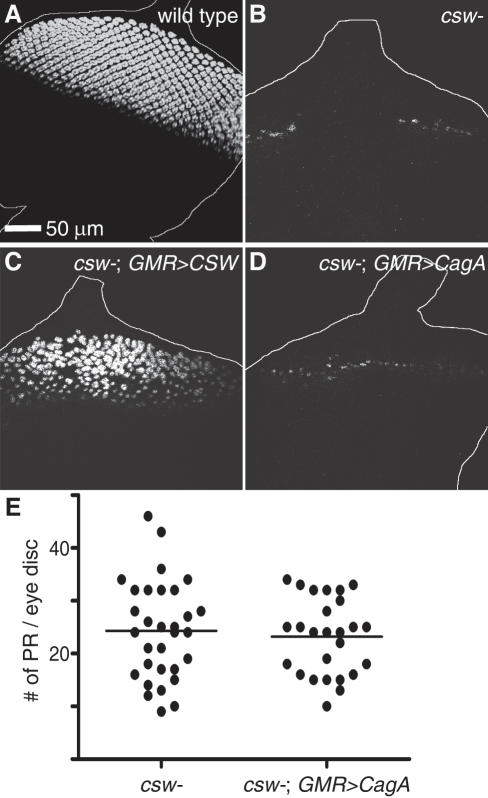
CagA's specification of photoreceptors requires SHP-2/CSW.(A) Wild type larval eye discs contain thousands of photoreceptors, which were visualized by anti-ELAV staining. (B) Few photoreceptors develop in csw mutant larval eye discs. (C) Expression of UAS-CSW using GMR-GAL4 in the csw mutant partially rescued the lack of photoreceptor development but expression of UAS-CagA did not (D). (E) There was no significant difference (T-test, p value>0.2) in the number of photoreceptors (PR) that developed in csw mutants with or without CagA expression.